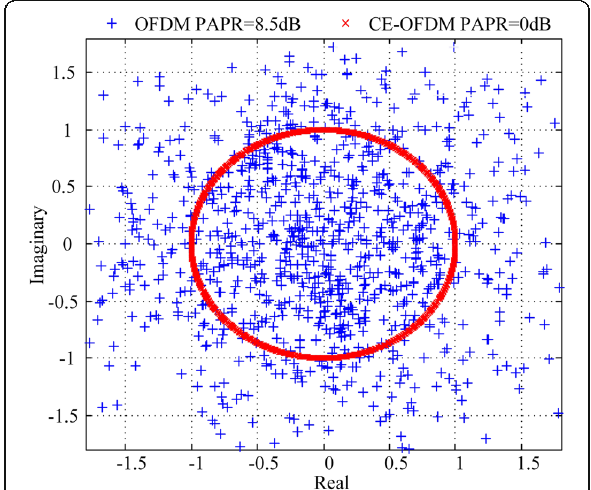
Fig. 3 Constellation diagram of OFDM and CE-OFDM random signals. Detailed legends: the plus sign represents the OFDM signals with 8.5 dB PAPR, and the cross represents the CE-OFDM signals